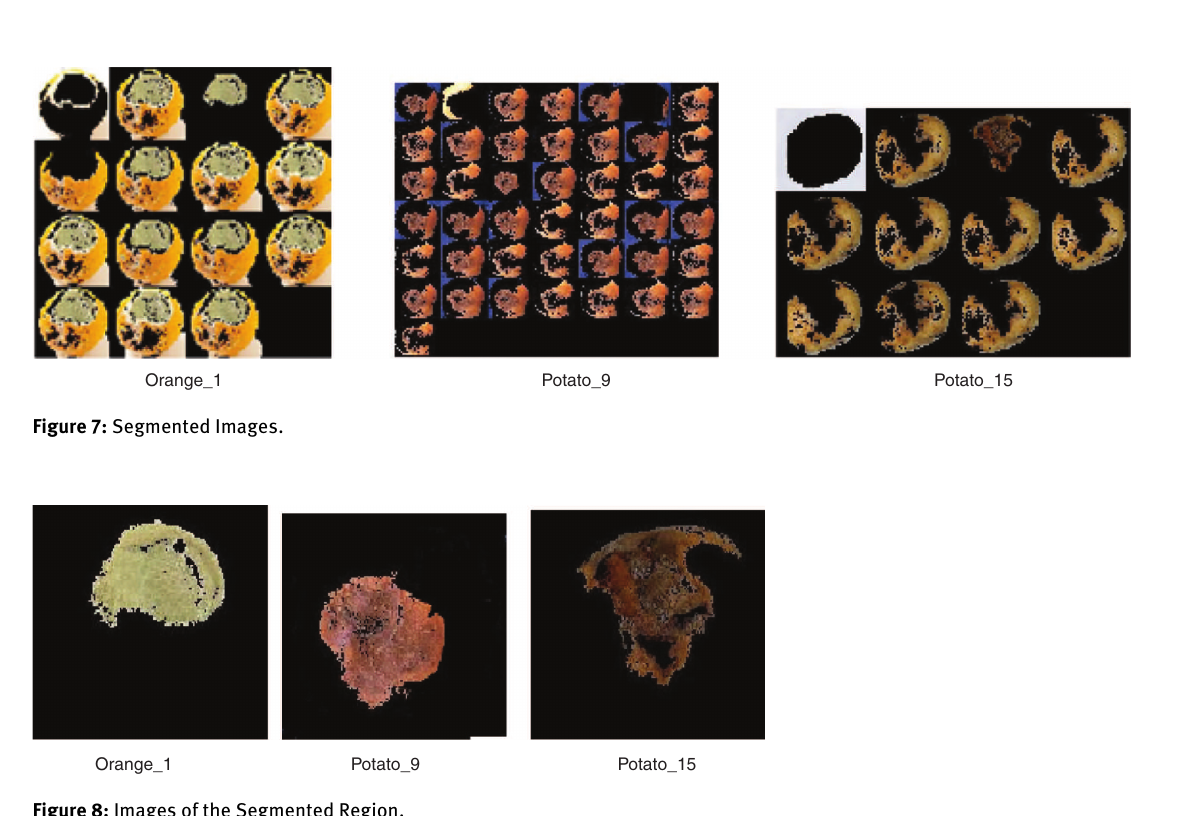
Figure 6: Preprocessed Images.